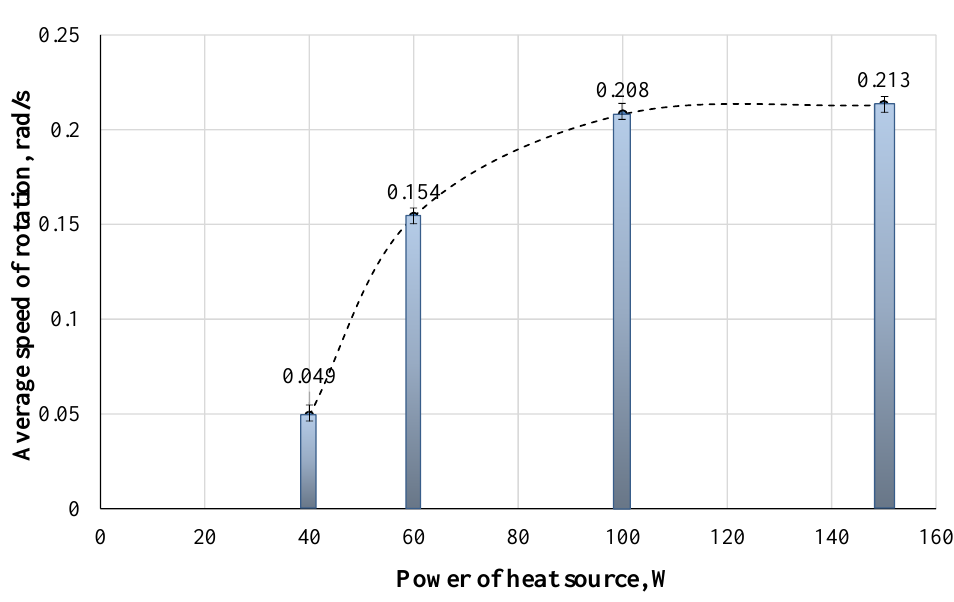
Figure 10. The relationship between the angular velocity of the broad leaved lime ( Tilia platyphyllos Scop ) leaf (leaf rotation) and the power of light source.